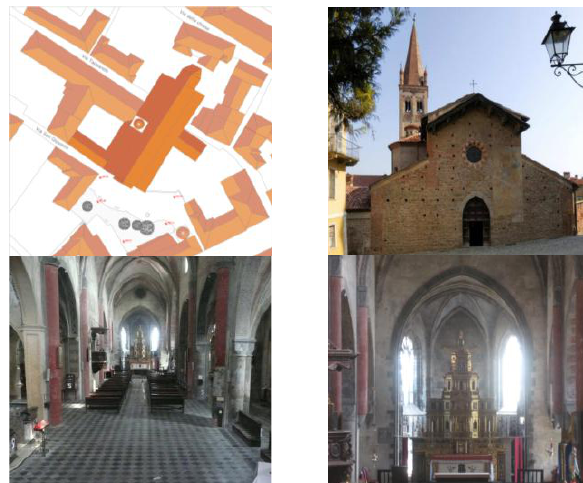
Figure 1. The church of San Giovanni: general map (original scale 1:500) and external view (top), interior overview (below).